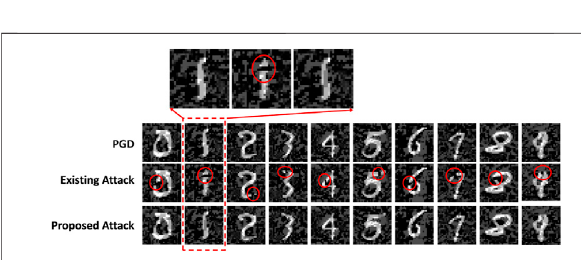
FIGURE 10 | Comparison of adversary attack images on MNIST. The disconnected positions are marked by red circles. The images generated by the proposed attack is with perturbations limited within [-0.2,